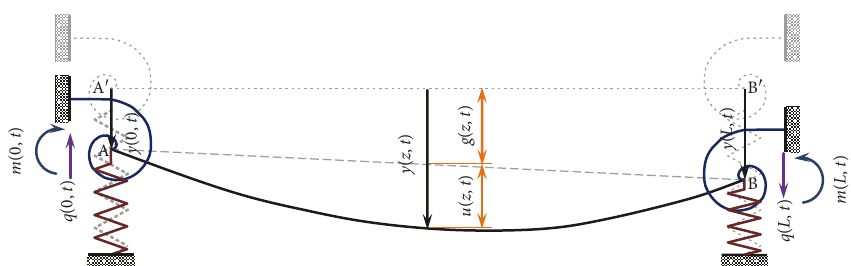
Figure 2: Transverse displacements and end forces of the Euler beam (the elastic foundation is omitted for a clear